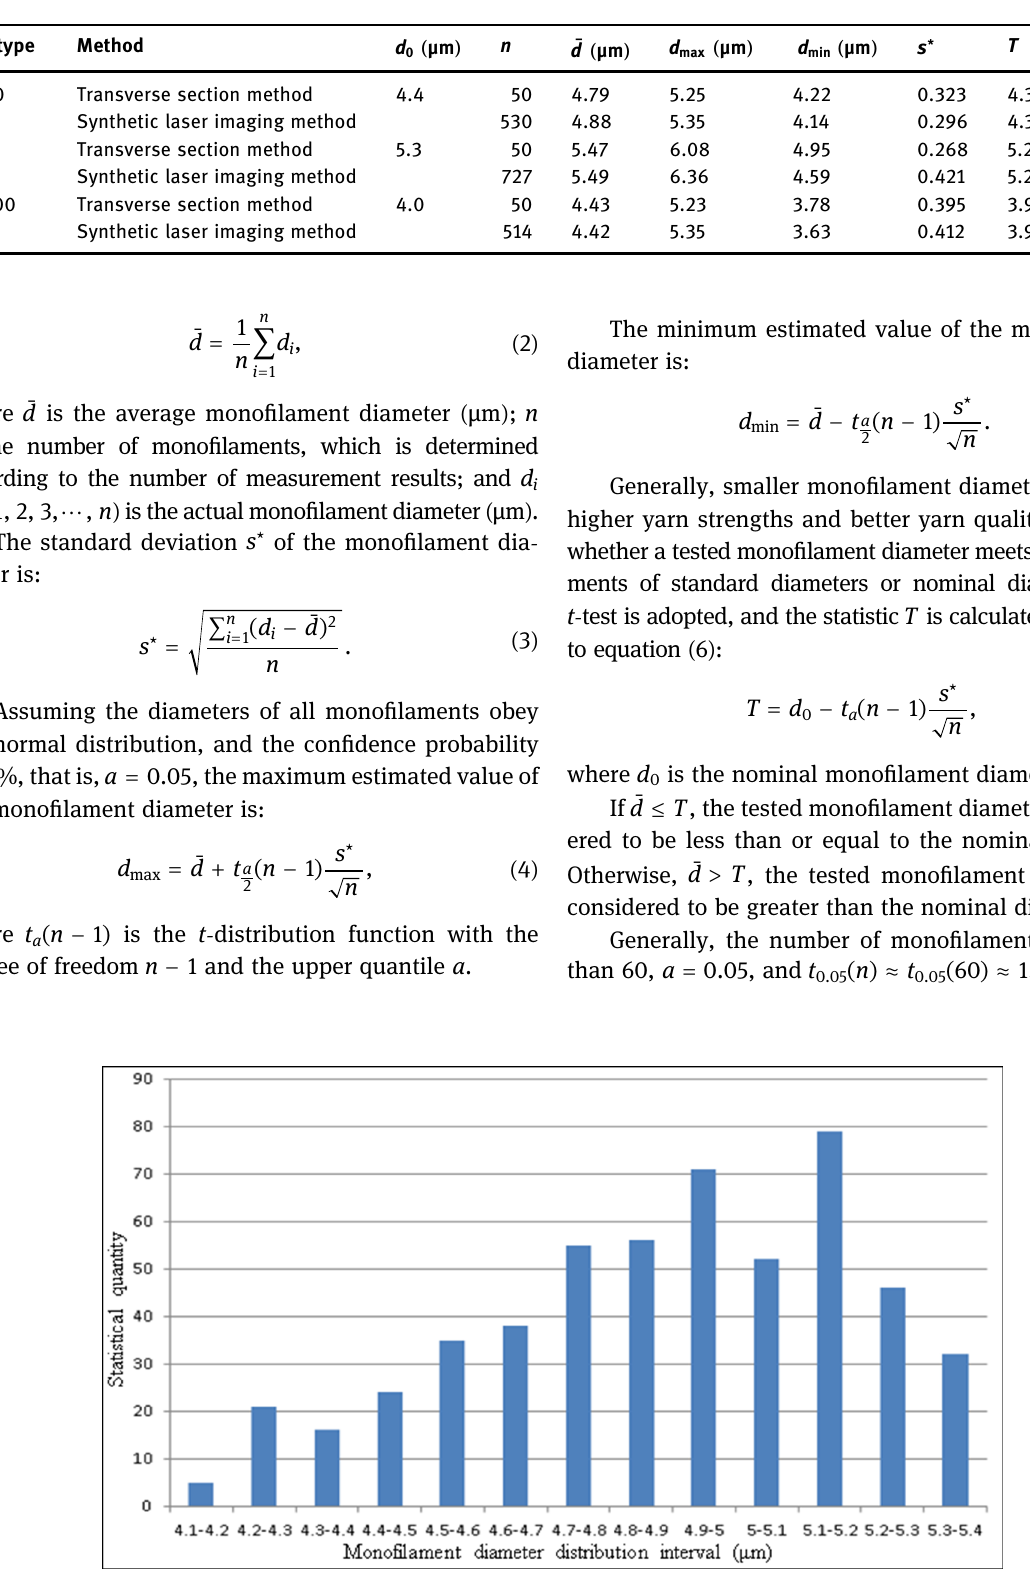
Figure 6: Mono fi lament diameter distribution for C1200 glass